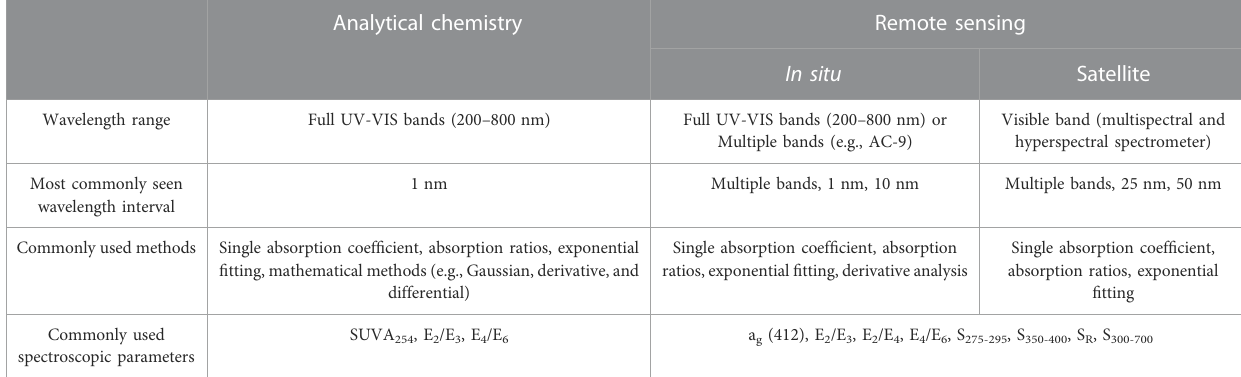
TABLE 1 Information content of UV-VIS spectroscopic methods for different user communities.